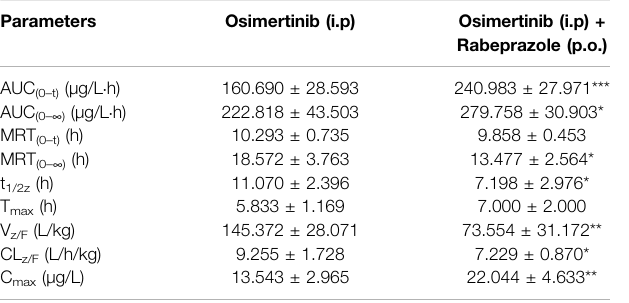
TABLE 4 | The main pharmacokinetic parameters of osimertinib in two groups of rats ( N = 6). Parameters Osimertinib (i.p) Osimertinib (i.p) +